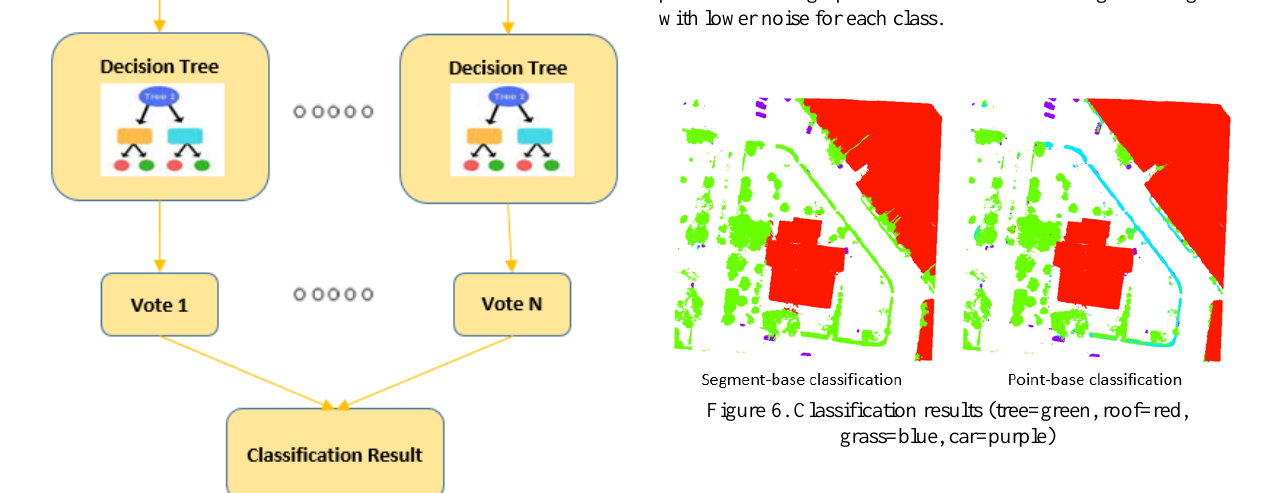
Figure 4. Random forest classification of feature vectors